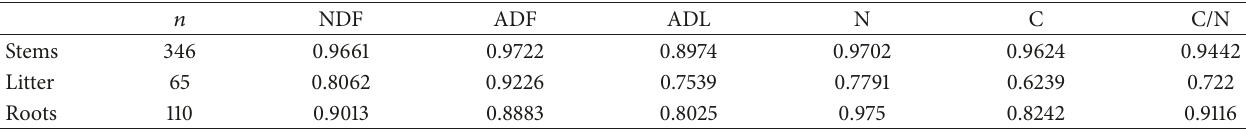
Table 5: Pearson correlation coefficients for residue traits of canola plant components measured using laboratory reference methods and compared to NIRS predicted values across all years, locations, and canola types. For each pair, the level of significance was < 0.0001 at 𝑃 < 0.05 . 𝑛 NDF ADF ADL N C C/N